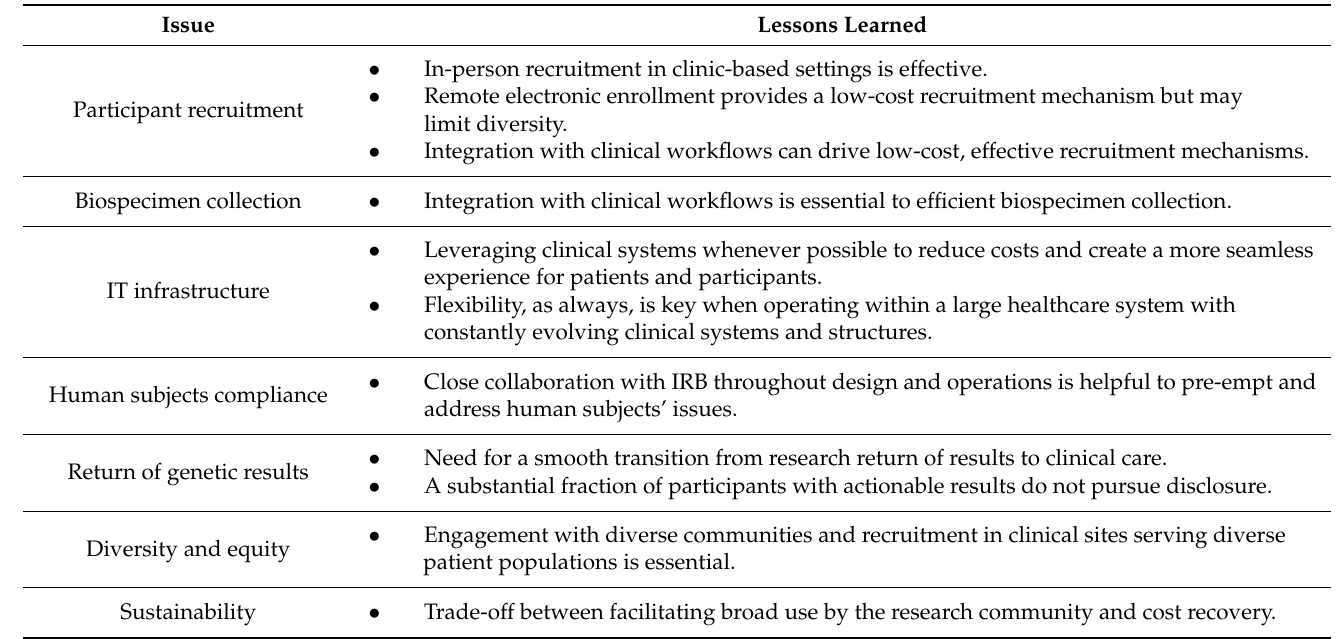
Table 7. Lessons Learned in the Development and Operation of the MGB